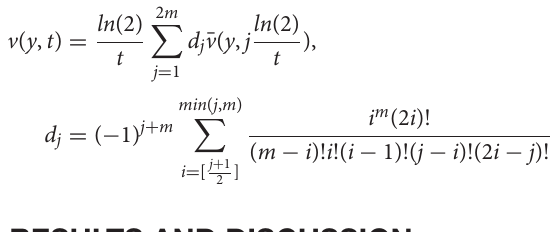
Figure 2 examines the behavior of α on concentration.